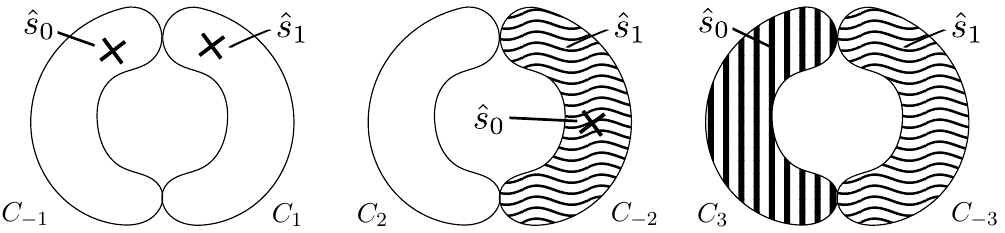
Figure 3 . Intersections between the two rational sections and the components of the three types of isolated (cid:12)bral curves in (cid:12)brations constructed from dP 1 (polytope F 3 ). Shaded components are wrapped by the rational section while crosses indicate a transverse intersection. The (cid:12)gures are taken from